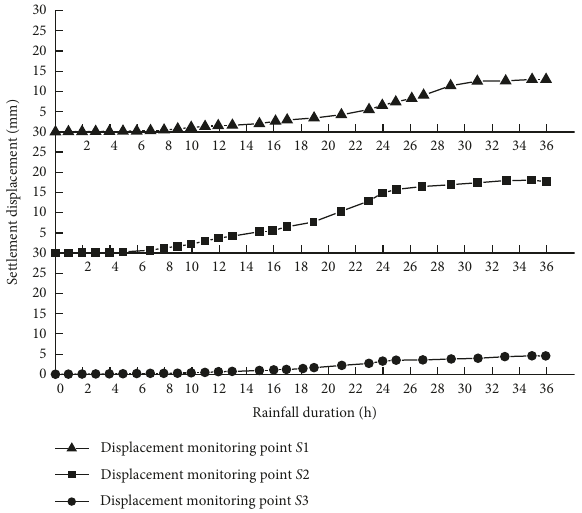
Figure 11: Variation law of settlement displacement under short- time